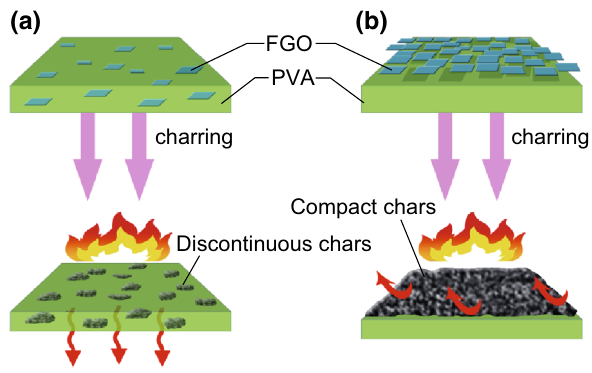
Fig. 9 Scheme of the flame-retardant behaviors of a PVA/FGO composite and b FGO multilayer-coated PVA